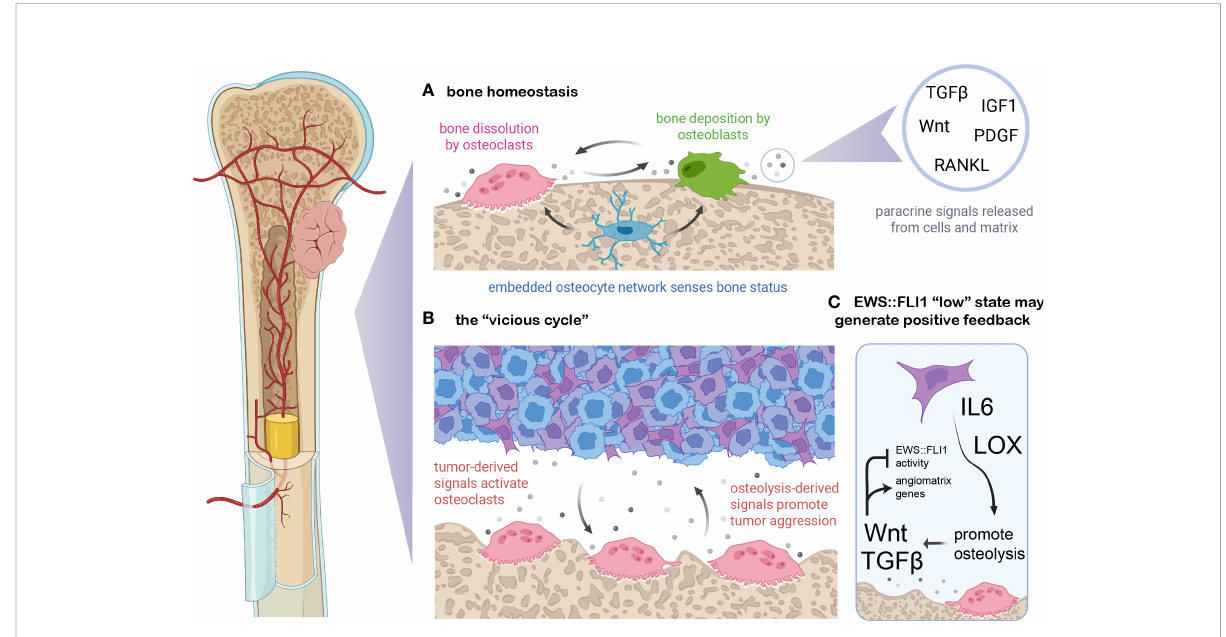
FIGURE 3 EWS::FLI1 activity is regulated by signals in the osteolytic bone tumor microenvironment. (A) Bone is constantly remodeled and homeostasis is maintained by osteoclasts (which resorb bone through protease and proton secretion), osteoblasts (which deposit mineralized, collagenous matrix), and osteoblast-derived osteocytes which form a network within bone and modulate osteoclast and osteoblast activity (110). Soluble signals exist either embedded in the bone matrix (and released upon dissolution) or generated via paracrine secretion from bone cells. These signals couple remodeling to deposition and shifts in these signals can either balance bone remodeling, favor deposition during periods of bone growth, or favor osteolysis during regression or calcium de fi ciency. (B) Ewing sarcoma cells can secrete numerous signals which dysregulate this balance, including osteoblast-activating factors such as RANKL, IL6, TNF-alpha, and LOX (109, 111 – 113). In turn, the dissolution of bone matrix releases embedded growth factors such Wnts, TGF-beta, PDGFs, FGFs, and IGF1 which can promote tumor growth and/or metastasis (111). (C) EWS::FLI1 “ low ” cells may generate a positive feedback loop with the osteolytic “ vicious cycle ” . Recent fi ndings suggest that bone- derived signals such as Wnt and TGF-beta partially antagonize EWS::FLI1 activity, promoting an EWS::FLI1 “ low ” transcriptional state that upregulates mesenchymal-identify genes including pro-metastatic ECM molecules and angiogenesis-inducing genes (23). EWS::FLI1 antagonism also induces expression of LOX and IL-6, known promoters of osteolysis (17, 35, 114). Figure created with